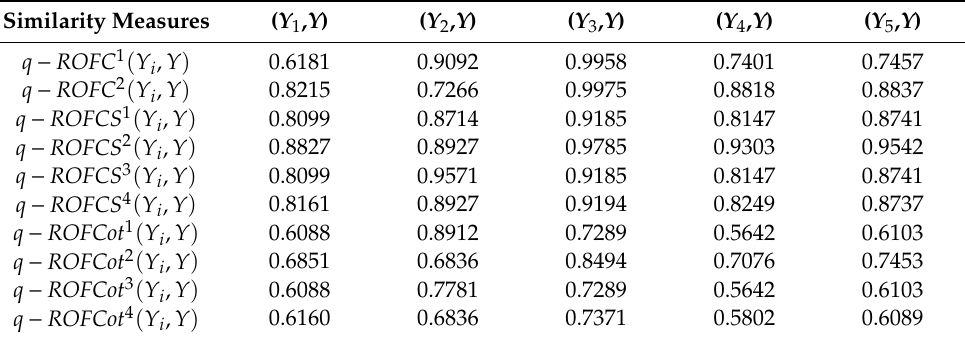
Table 4. The similarity measures between Y i ( i = 1,2,3,4,5 ) and Y +